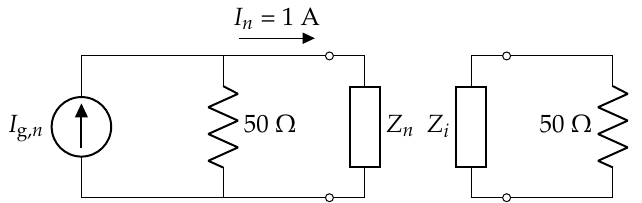
( x , y , z ) . The goal is to O ( x n , y n , z n ) . The circumscribing O n on the entire array. n